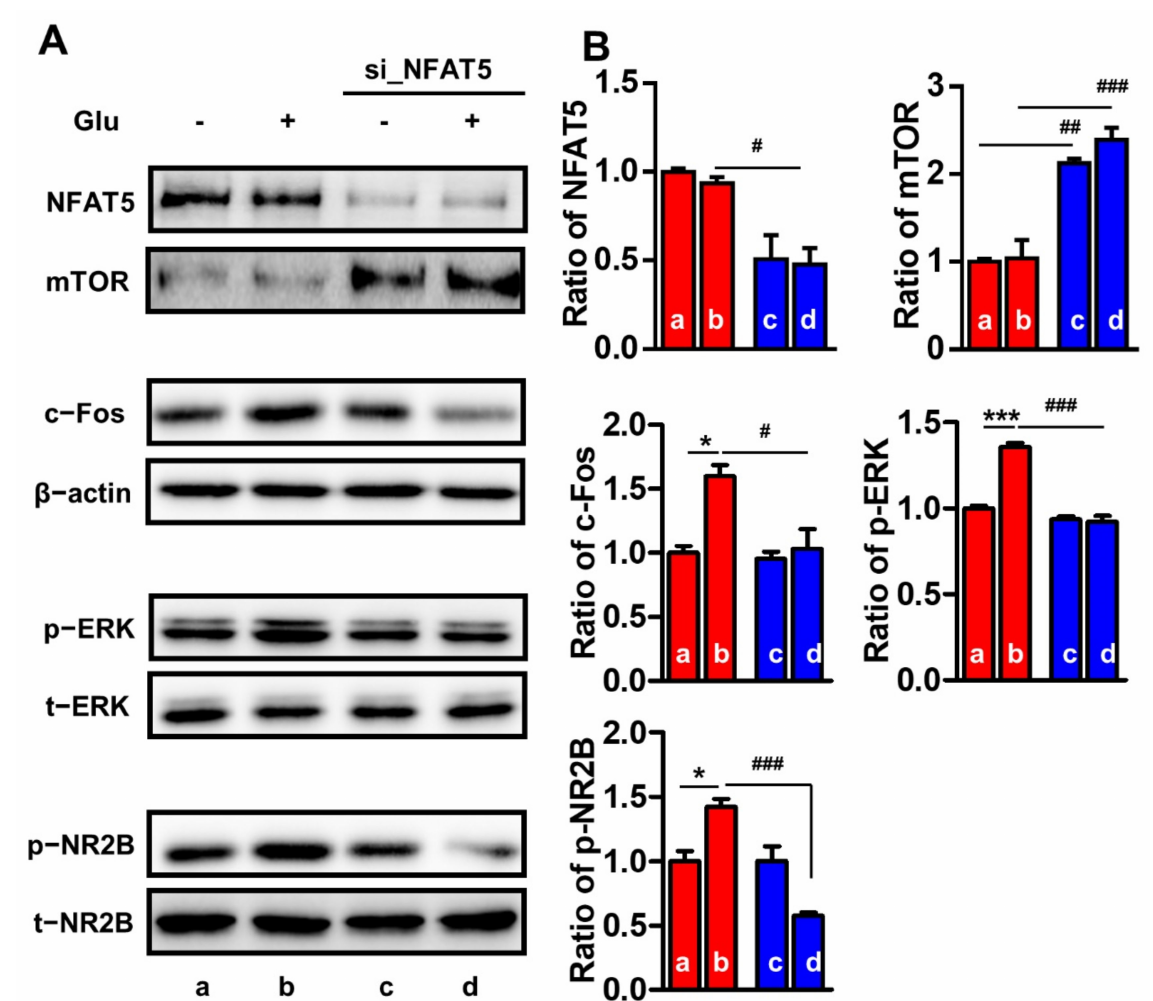
Figure 7. The expression of mTOR and inflammatory pain-related proteins in NFAT5-silenced PC12 cells. ( A ) The expression levels of NFAT5, mTOR, and inflammatory pain-related factors were examined using Western blot analysis in normal PC12 cells and NFAT5-silenced PC12 cells in the absence or presence of 100 µ M glutamate. ( B ) Band intensities represented as the ratios of NFAT5, mTOR, and c-Fos normalized to β -actin; p-ERK normalized to total (t)-ERK; and p-NR2B normalized to t-NR2B. Data are expressed as the means ± SEMs (one-way ANOVA with Tukey’s post-hoc test, * p < 0.05 vs. WT formalin, *** p < 0.001 vs. a (negative control), # p < 0.05 vs. b (glutamate treatment), ## p < 0.01 vs. b, ### p < 0.001 vs. b, n =